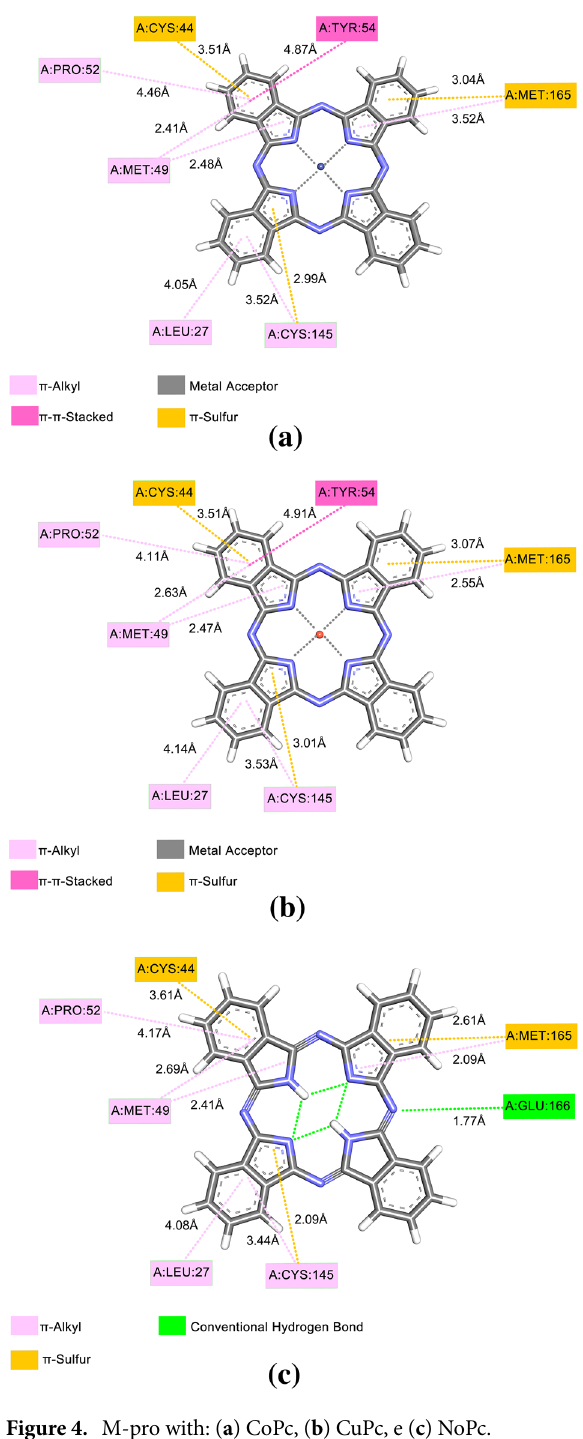
Figure 4. M-pro with: ( a ) CoPc, ( b ) CuPc, e ( c )